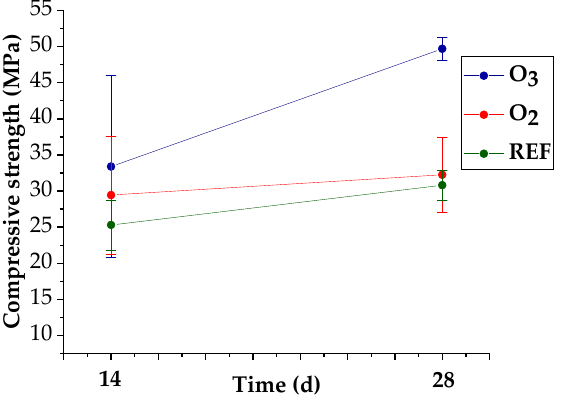
Figure 6. Compressive strength results of the tested concretes.